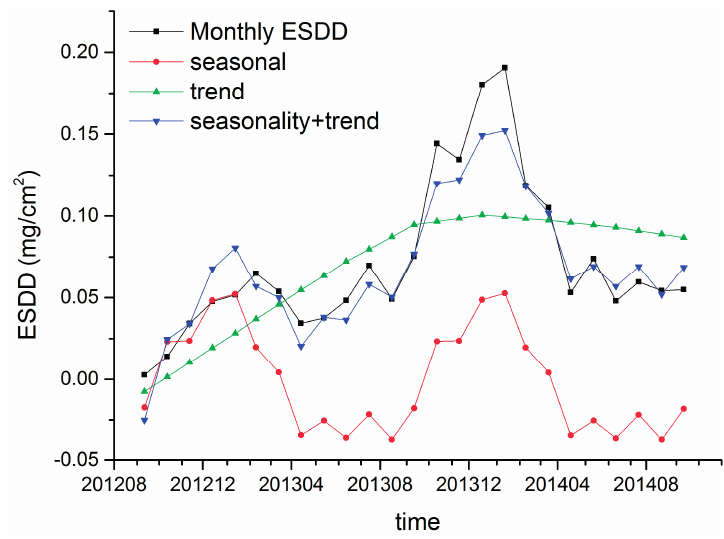
Figure 13. Decomposition results of Xiangyang